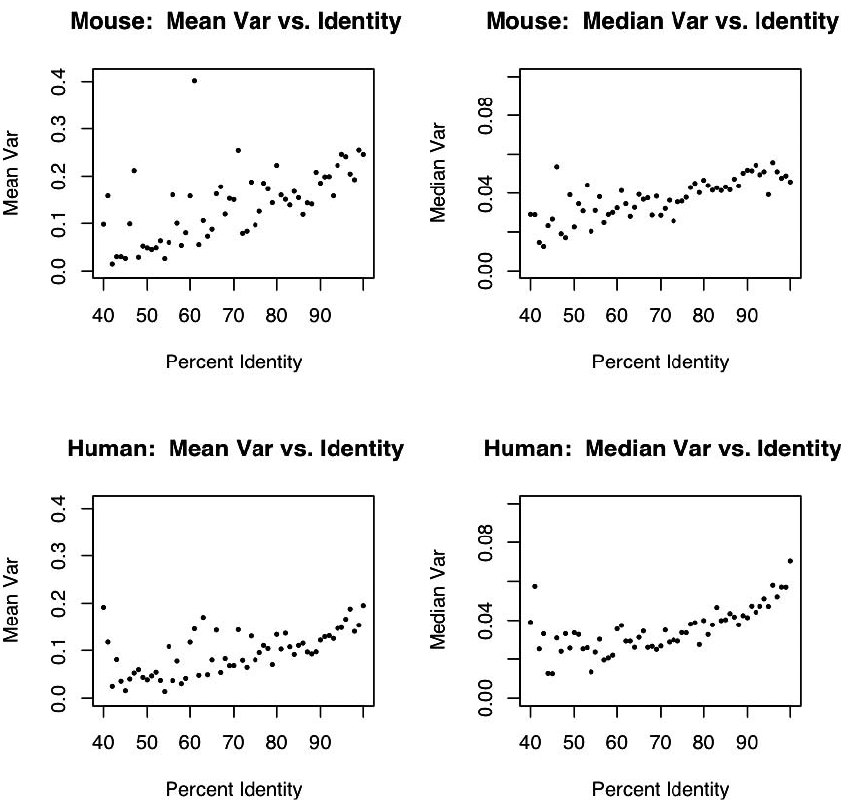
Figure 3. Genes with High Variance across Tissues Have Greater Conservation of Nucleotide Sequence Orthologous mouse and human gene pairs were binned according to their nearest integral percent identity. The mouse or human mean and median variance of each bin are plotted against the bin’s percent